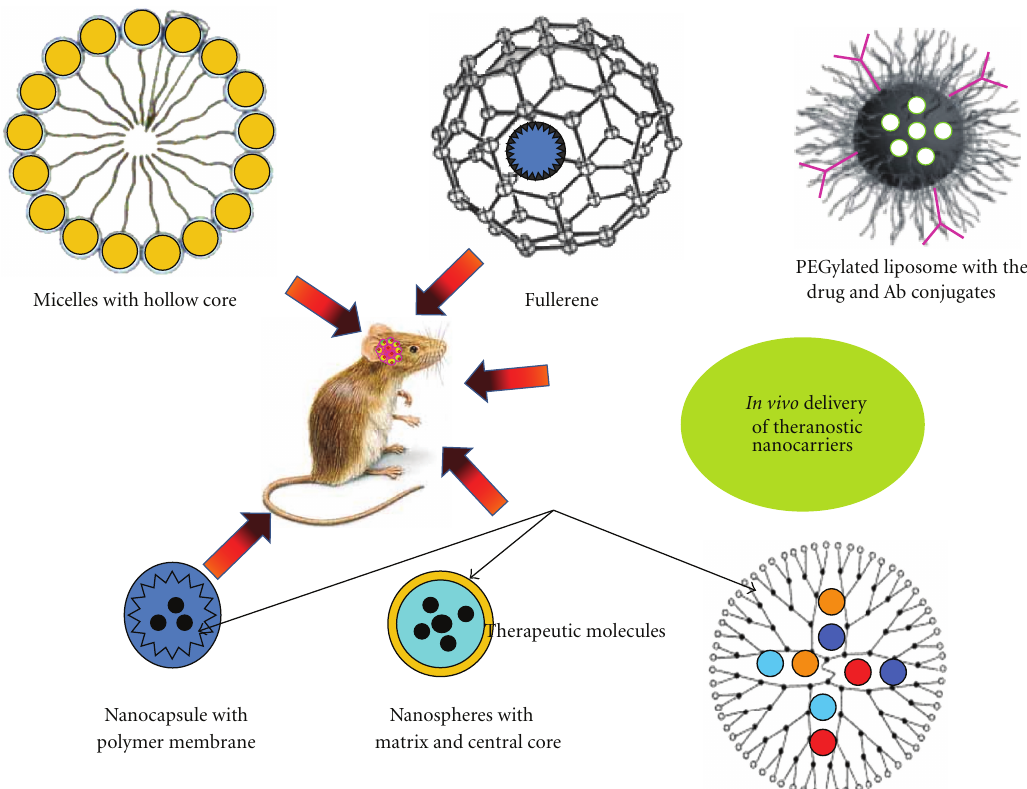
Figure 3: Polymeric nanocarriers in current CNS disorders. Micelle core is promising site for loading insoluble therapeutic agents, while liposome can be targeted by conjugating Ab linker. Fullerene cage surfaces can be functionalized for targeted delivery. Branched dendrimers and nanocapsules are potential nanotheranostic